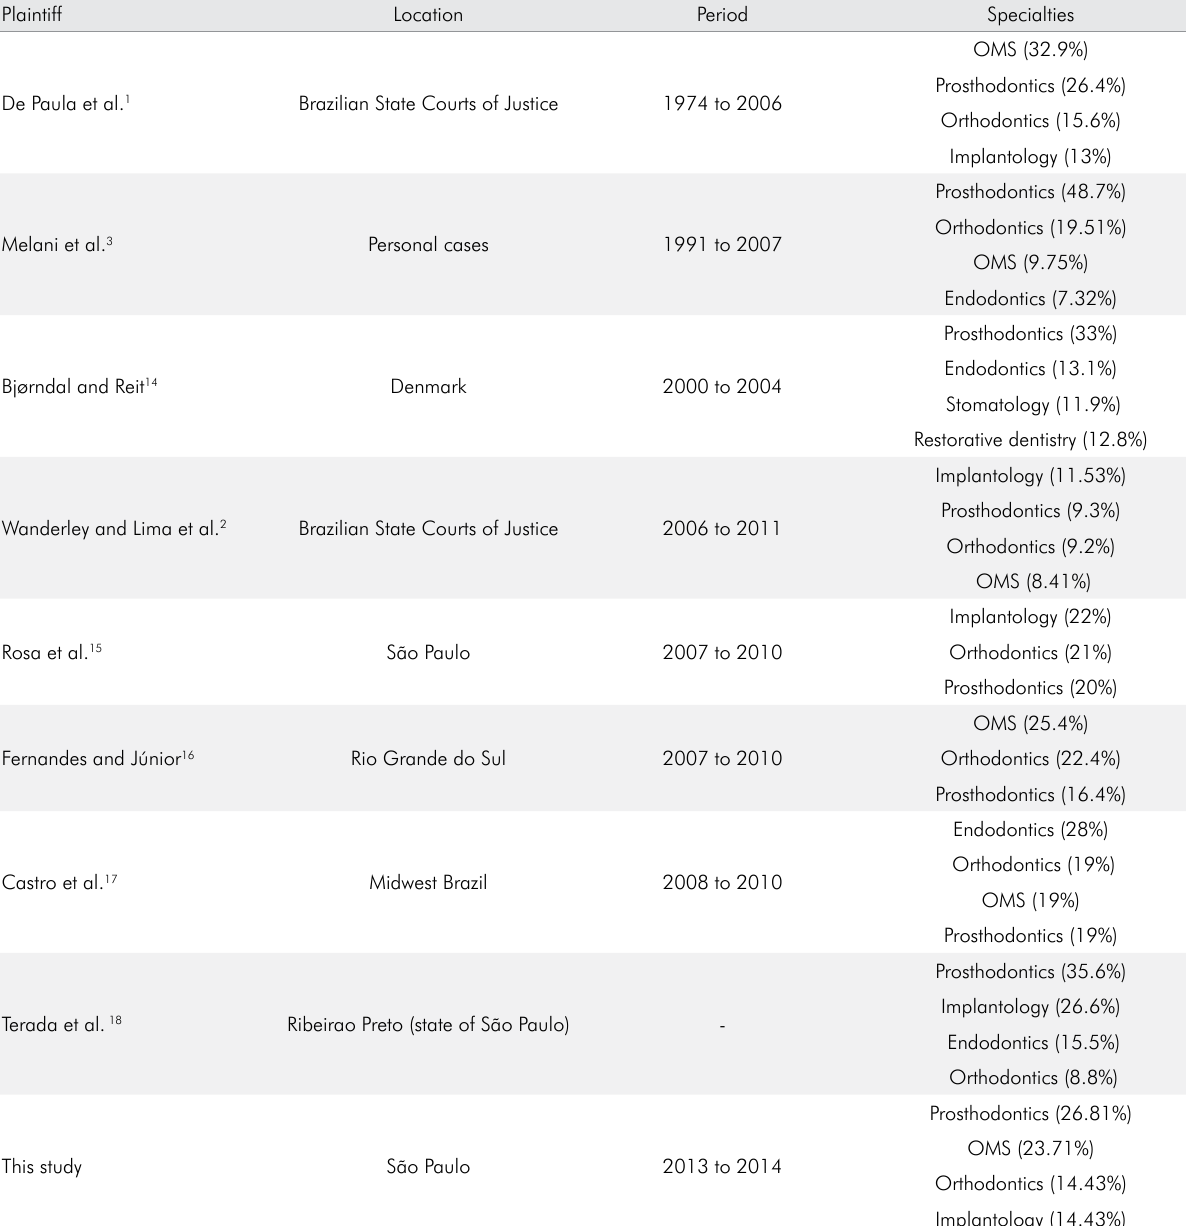
Table 2. Specialties most frequently involved in civil liability lawsuits against